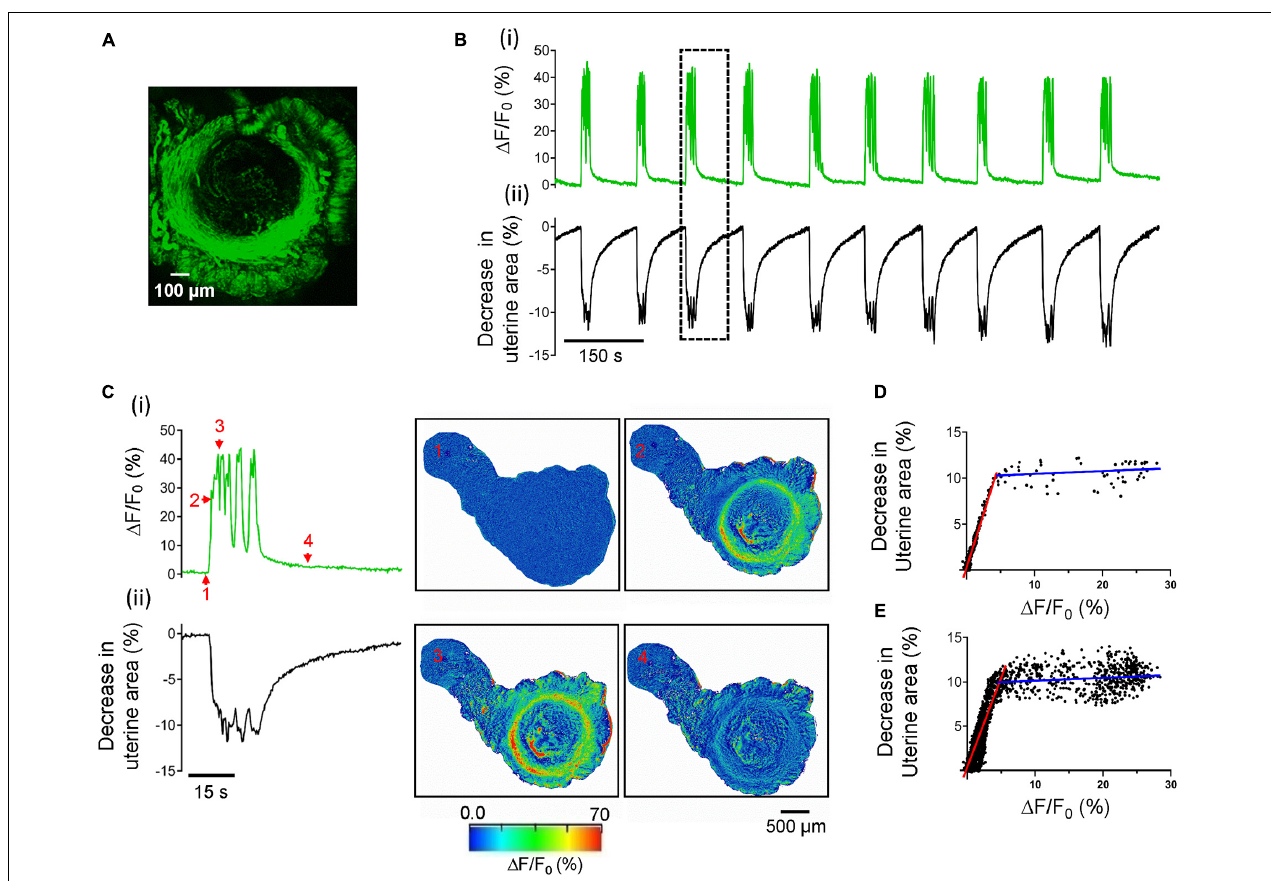
FIGURE 1 | Ca 2 + oscillations cause uterine peristalsis in precision-cut mouse uterine slices. (A) A uterine slice from α SMA-hrGFP mice shows GFP positive signals only in circular and longitudinal myometrial layers. (B) Temporal relationship between Ca 2 + oscillations and uterine peristalsis in a precision-cut mouse uterine slice. (cid:49) F / F 0 (%) [B(i)] , a proxy for [Ca 2 + ] i , was the averaged value of the entire circular myometrium, while changes in the uterine area [B(ii)] were calculated using the whole slice. The event within the dotted line box is shown on an expanded scale in panel (C) . [C(i)] The evolution of a burst of Ca 2 + oscillations; [C(ii)] The evolution of associated uterine peristalsis. The images on the right display temporal changes in the uterine area and the fluorescence as (cid:49) F / F 0 (%), and numbers in the images correspond to those marked near the green line in panel C(i) . Note that red signals near the edge of the slices in this figure (and in Figures 6C , 8C ) are the artifacts due to the slice contraction and relaxation. (D) Relationship between [Ca 2 + ] i and associated decreases in the uterine area for the event in panel (C) . (E) Relationship between [Ca 2 + ] i and associated decreases in the uterine area from all the events in panel (B) . Red and blue lines in panel (D,E) are the fitting results of two ranges of (cid:49) F / F 0